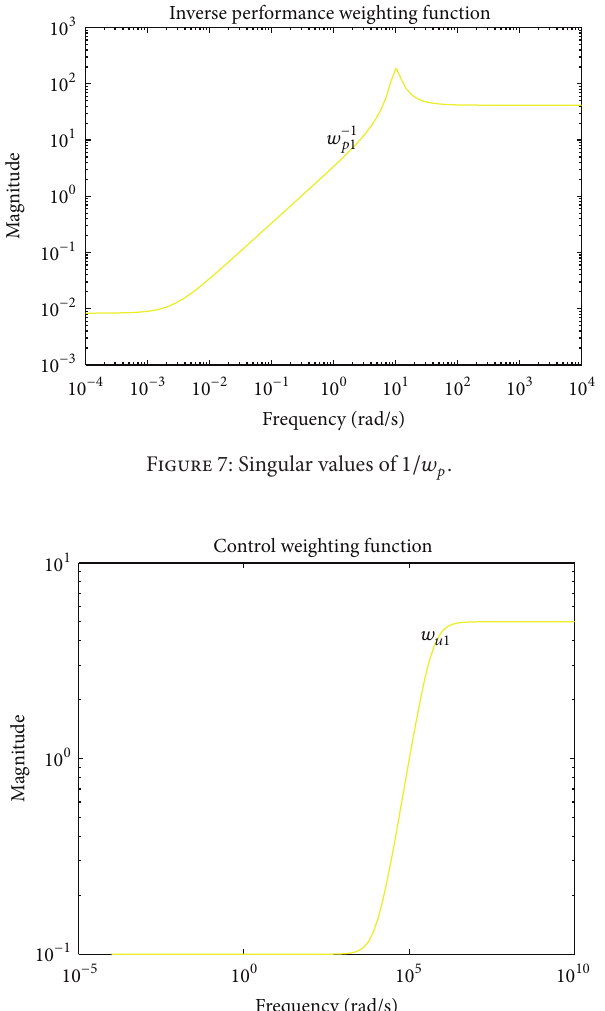
Figure 8: Singular values of 𝑤 𝑢